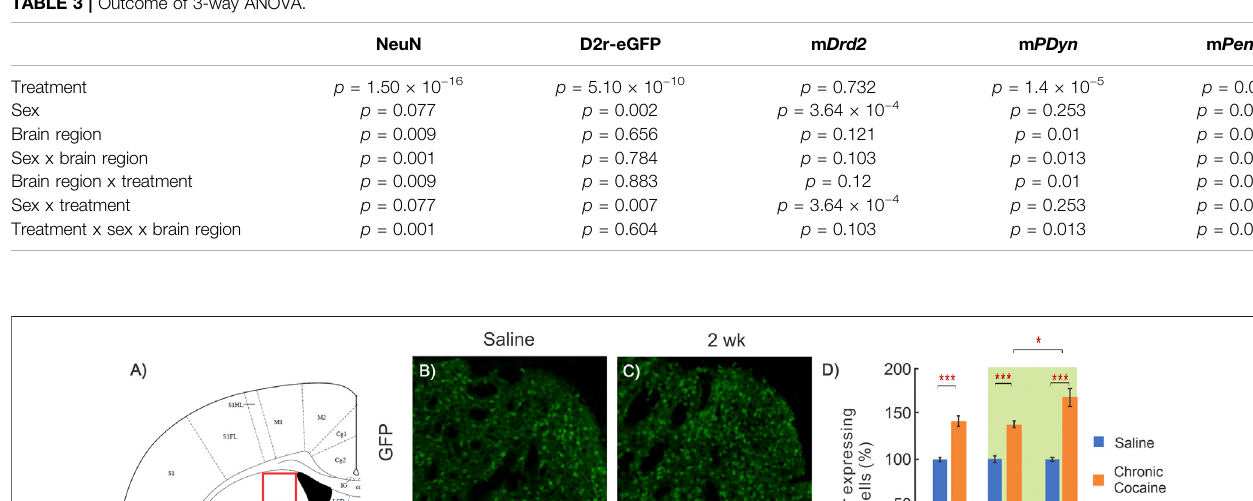
1.4 × 10 − 5 ); signi fi cant sex effects were recognized on both D2r- GFP ( p (cid:2) 0.002) and Drd2 mRNA levels ( p (cid:2) 0.00036), also for m Penk ( p (cid:2) 0.025) but not for NeuN or m Pdyn . Among all the